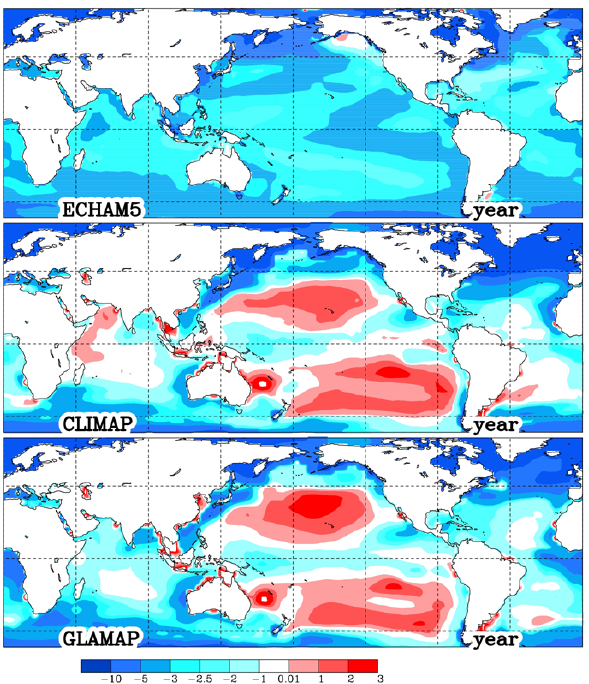
Fig. 1. Annual mean SST differences between the LGM and the present (NOW). Contours at − 10, − 5, − 3, − 2.5, − 2, − 1, − 0.01, 1, 2, 3 ◦ C. Data from the models used here are surface temperatures which over sea ice can become very low.